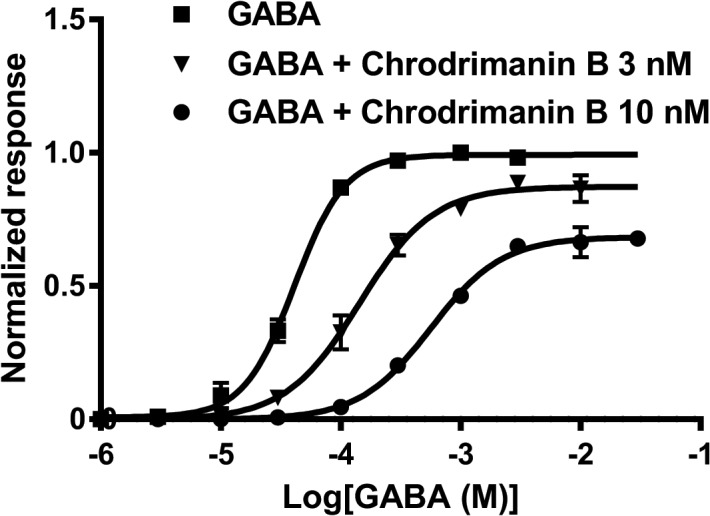
Effects of chrodrimanin B on the concentration-response curve for GABA on silkworm RDL GABAR expressed in Xenopus oocytes.The GABA-induced responses were measured at various concentrations in the presence and absence of chrodrimanin B. The EC50 value for GABA shifted from 41.1 μM (n = 4, CI = 37.3–45.2 μM) without chrodrimanin B to 143 μM (n = 4, 121–170 μM) with 3 nM chrodrimanin B and to 565 μM (n = 4, 478–668 μM) with 10 nM chrodrimanin B, respectively.